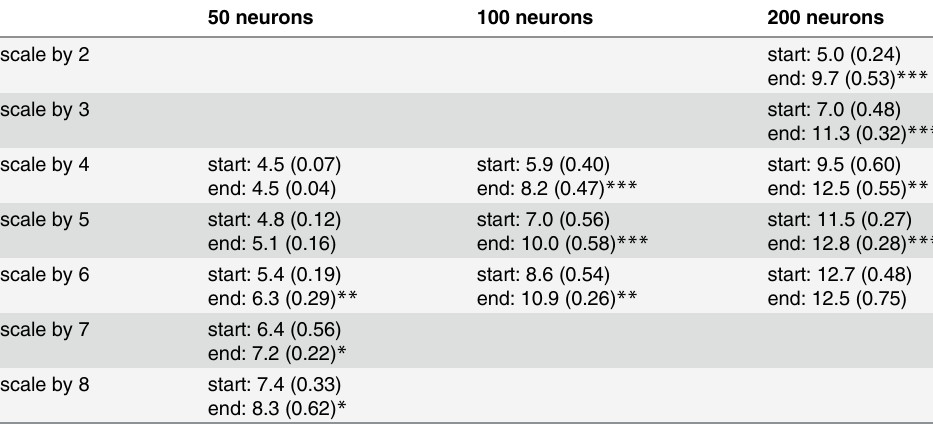
Beginning and ending salience as a function of number of output and motor neurons and scaling from motor activity to muscle activity. The start values are the average salience over the fi rst 60 sounds (i.e. the fi rst simulated minute ’ s worth of vocalization) for the fi ve simulations using that cell ’ s parameter combination. The end values are the average salience over the last 60 sounds (i.e. the 120th simulated minute ’ s). Standard deviations of the mean values across simulations are in parentheses. Asterisks indicate where a paired t-test found a signi fi cant difference between the average Minute 1 salience and the average Minute 120 salience across the fi ve simulations, * p < .05, ** p < .01, *** p < .001. Blank cells indicate parameter combinations that were not